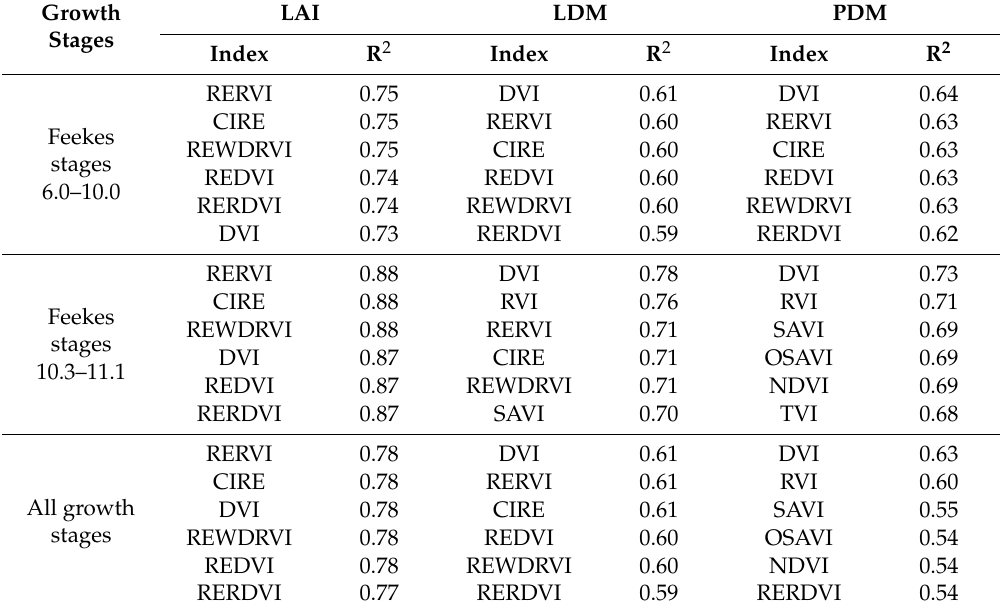
Table 4. Coe ffi cients of determination (R 2 ) for pair-wise associations between top 6 vegetation indices and leaf area index (LAI), leaf dry matter (LDM), and plant dry matter (PDM) at di ff erent growth stages across varieties, sites (Sihong and Rugao), and years (2015–2017). The full name of each vegetation index is shown in Table